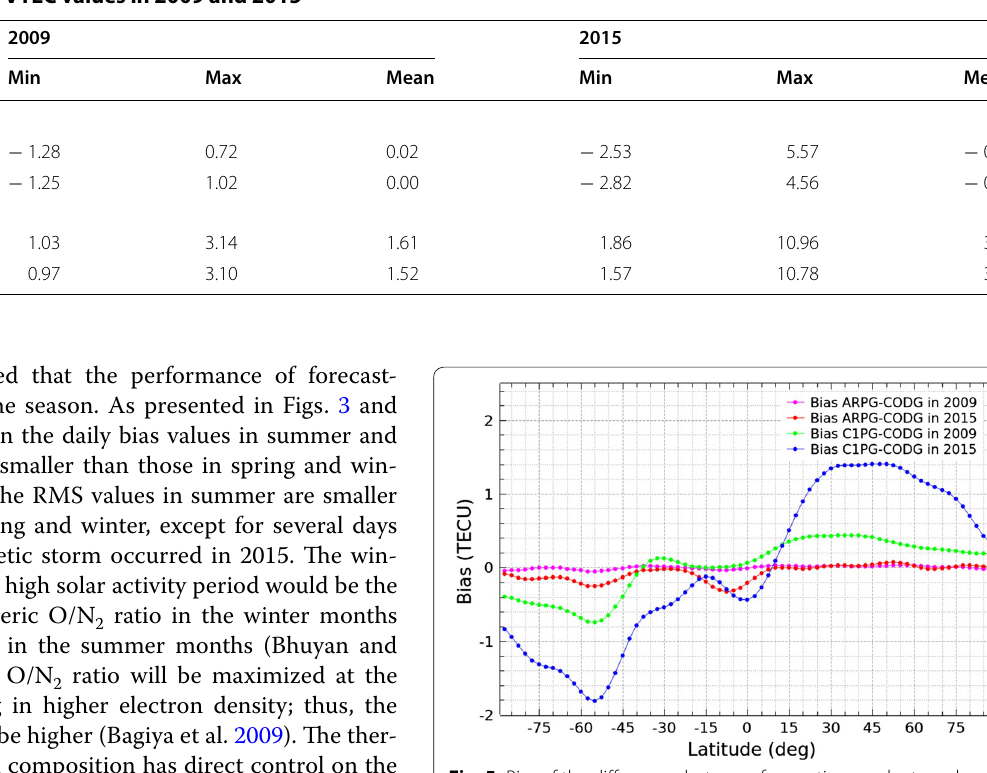
Fig. 5 Bias of the differences between forecasting products and the final CODG in 2009 and 2015. The magenta and red dotted lines depict the bias between ARPG and CODG in 2009 and 2015, respec- tively. The green and blue dotted lines depict the bias between C1PG and CODG in 2009 and 2015,